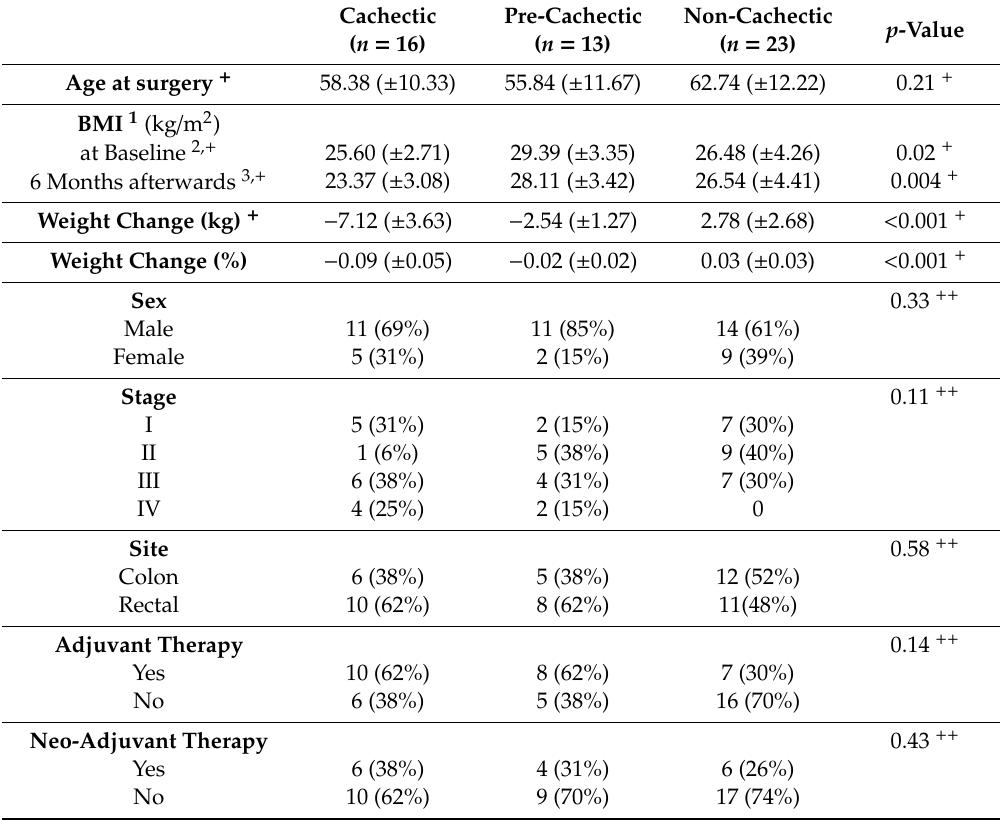
Table 2. Description of cachectic, pre-cachectic, and non-cachectic